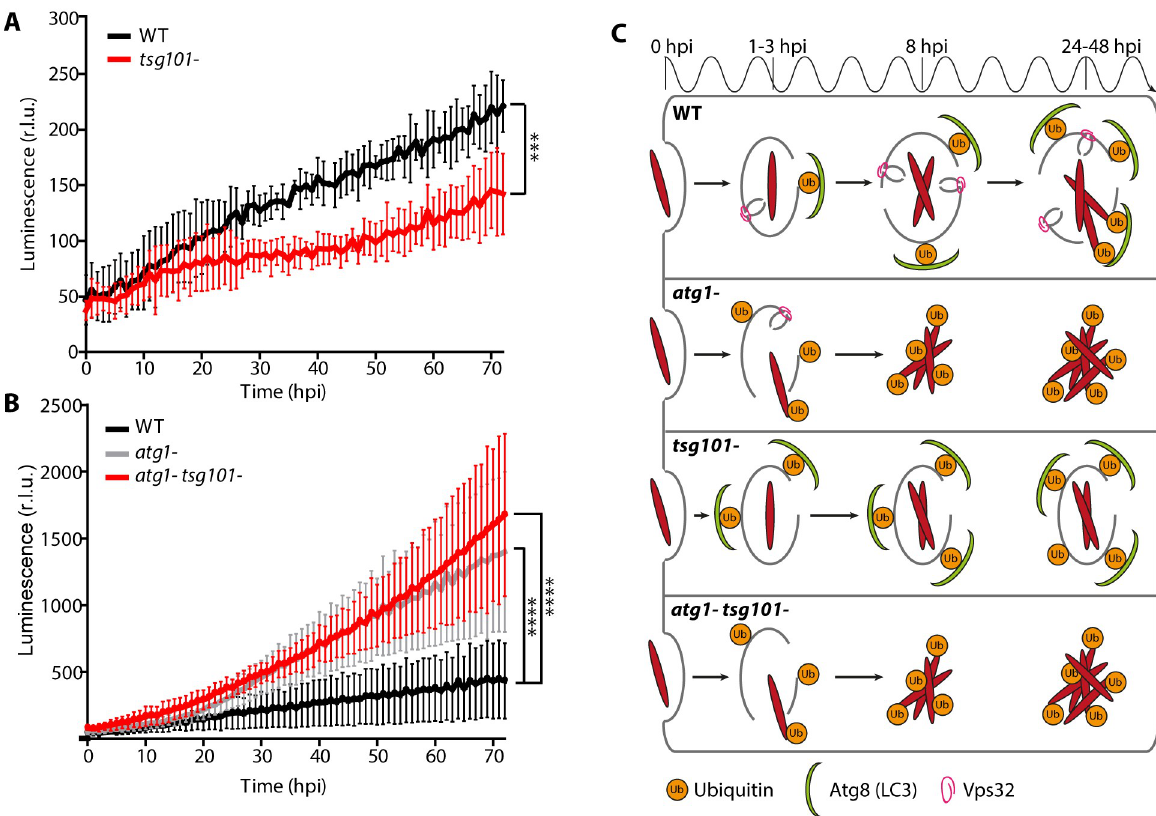
Fig 8. Impact of ESCRT and autophagy on mycobacterial growth. (A-B) Wt or mutant D . discoideum were infected with luminescent M . marinum and intracellular bacterial growth was monitored in a plate reader over 72 hpi. M . marinum growth was restricted in the tsg101- mutant, whereas it hyperproliferates in the atg1- and the double atg1- tsg101- mutant. Plots represent the mean and standard deviation of N = 3 independent experiments. Two-way ANOVA and post hoc Fisher’s LSD test were performed. (C) Model of autophagy and ESCRT-III involvement in MCV repair and restriction of M . marinum intracellular growth. In wt D . discoideum , M . marinum induces ESX-1-dependent injuries in the MCV membrane. This leads to the separate recruitment of the ESCRT-III and autophagy machineries to repair the damage, but nevertheless the bacteria are able to access the cytosol at later stages of infection (24–48 hpi). In the atg1- mutant, M . marinum access the cytosol earlier, despite the membrane repair exerted by ESCRT-III. Bacteria accumulate ubiquitin and proliferate more extensively in the cytosol devoid of a functional autophagy pathway. In the tsg101- mutant, membrane damage not repaired by ESCRT-III leads to an increase of ubiquitination and recruitment of the autophagy machinery, resulting in restriction of M . marinum growth. In a double atg1- tsg101- mutant, lack of both ESCRT-III and autophagic membrane repairs leads to an earlier access of bacteria to the cytosol, which accumulate ubiquitin and hyperproliferate as in the single atg1-